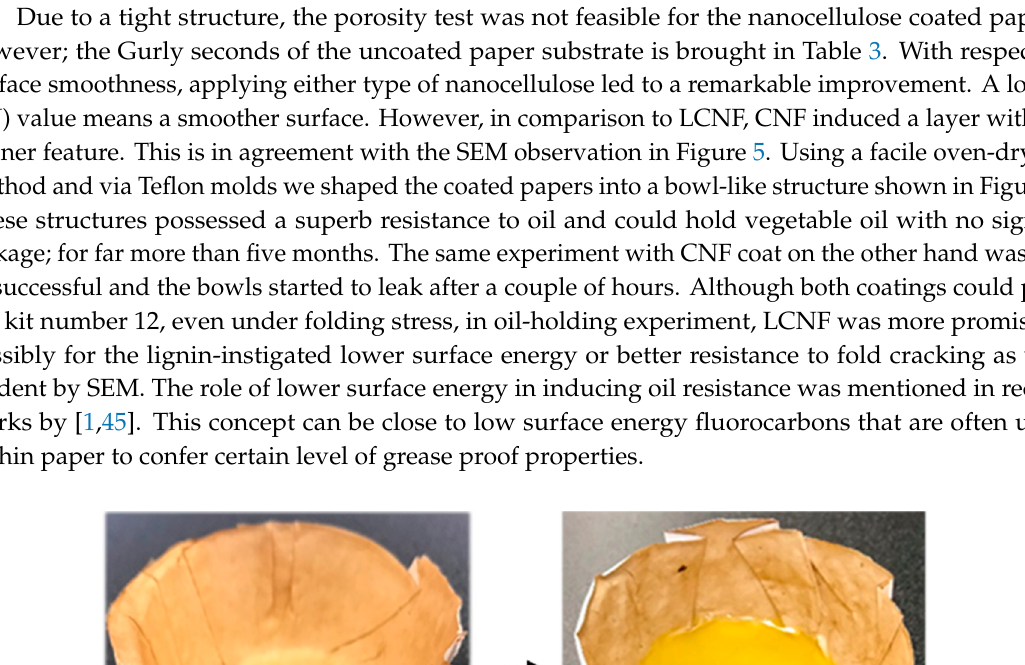
Figure 8. ( a ) Thermogravimetric analysis obtained from CNF and LCNF and ( b ) the corresponding derivative TG graphs . 3. Conclusions The barrier and physical properties induced by CNF and LCNF when applied on a regular paper substrate are compared. While CNF caused better oxygen barrier properties, LCNF exhibited higher grease resistance even while forming a shape. Both types penetrated the outermost interfiber network of the base paper and positively altered the elongation at break and tensile strengths, though CNF gave slightly better results. The superb oil resistance in LCNF can be ascribed to the lower polar nature and less surface energy of lignin compared to cellulose, although the actual mechanism is not fully discovered. A key result is that good properties are obtained using unbleached fibers to produce LCNF instead of using bleached fibers to produce CNF, especially when the goal is to produce a